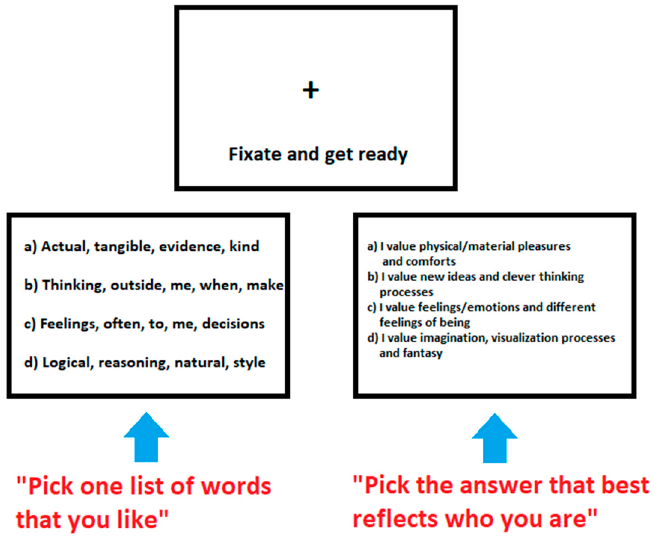
Figure 1. Three components of the block design protocol. The tasks were sectioned into three components of varying demand: Fixation -Rest ( top ), Words task ( left ) and Sentences self-reflection task ( right ). Examples of the words and sentences used are illustrated. 209